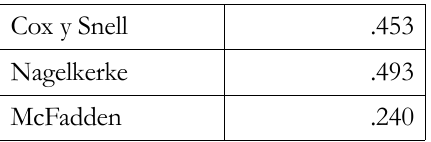
Table 5. Pseudo R- squared of model on e-Business